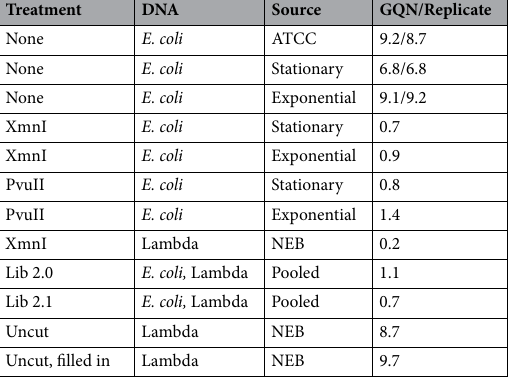
Table 2. Fragment Analyzer Relative Lengths with GQN10